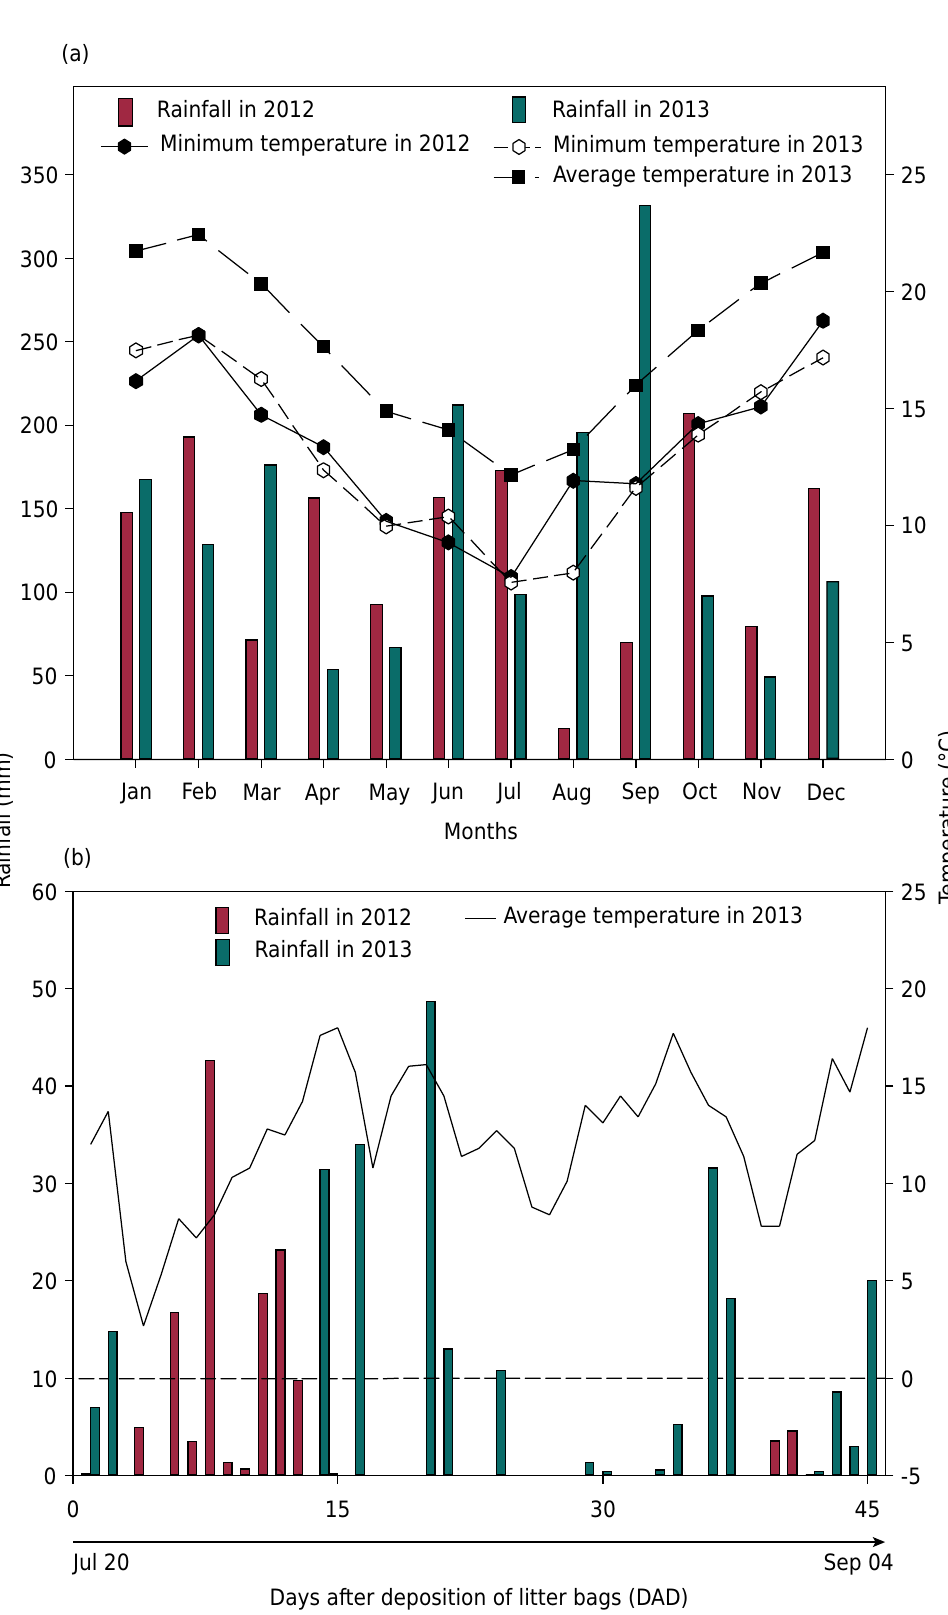
Figure 1. Monthly average rainfall and monthly average and minimum temperature in 2013 (a); Rainfall and daily average temperature in 2013 at 0, 30, and 45 DAD in the experimental area